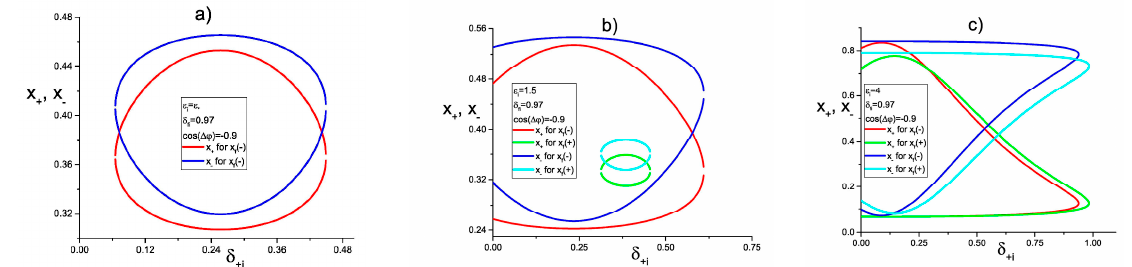
Figure 4. ( a ) Energies of the positron (red) and the electron (blue) of pair as functions of parameter δ + i for initial electron energy ε i = ε ∗ , parameter δ fi = 0.97, the final electron energy x f ( 0.97 ) ≈ 0.23 and azimuthal angles difference cos ( ϕ fi − ϕ + i ) = − 0.9. ( b ) The positron (red) and the electron (blue) energies as functions of parameter δ + i for low final electron energy x f ( 0.97; − ) ≈ 0.21 and the positron (green) and the electron (cyan) energies as functions of parameter δ + i for high final electron energy x f ( 0.97; +) ≈ 0.31 for initial electron energy ε i = 1.5, parameter δ fi = 0.97, and azimuthal angle difference cos ( ϕ fi − ϕ + i ) = − 0.9. ( c ) The positron (red) and the electron (blue) energies as functions of parameter δ + i for low final electron energy x f ( 0.97; − ) ≈ 0.09 and the positron (green) and electron (cyan) energies as functions of parameter δ + i for high final electron energy x f ( 0.97; +) ≈ 0.14 for initial electron energy ε i = 4, parameter δ fi = 0.97, and azimuthal angles difference cos ( ϕ fi − ϕ + i ) = − 0.9.